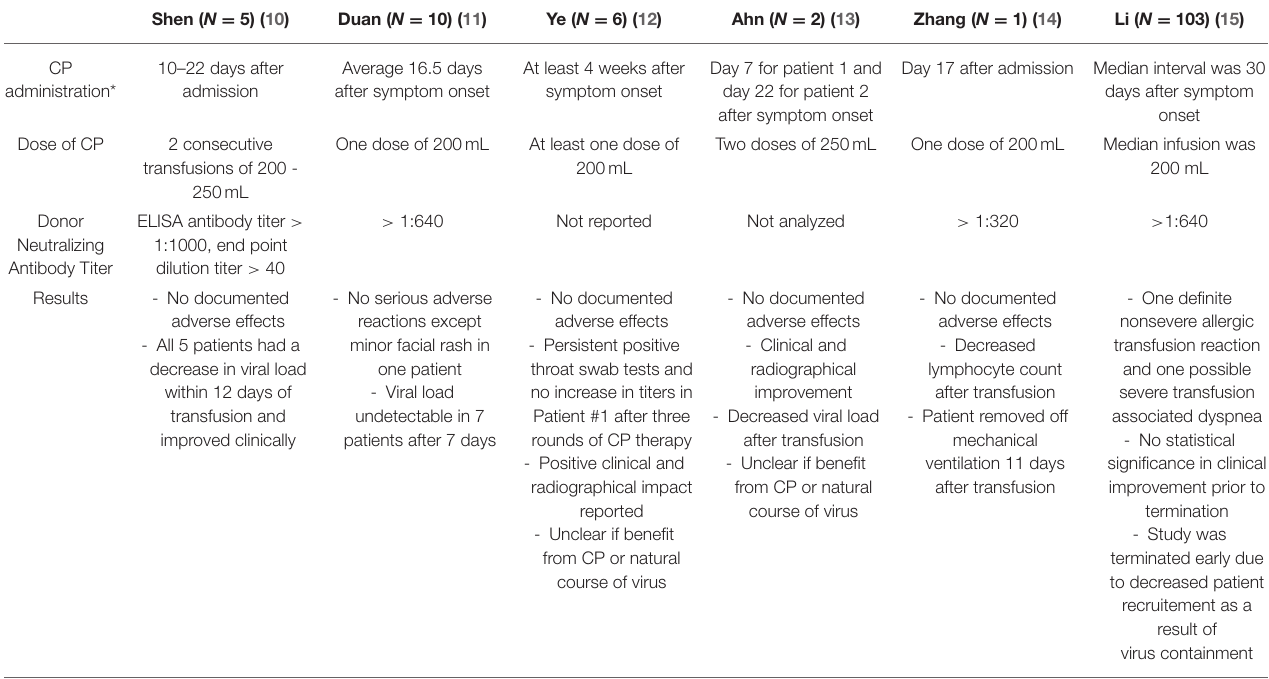
TABLE 1 | Summary of recently published studies of convalscent plasma transfusion in COVID-19